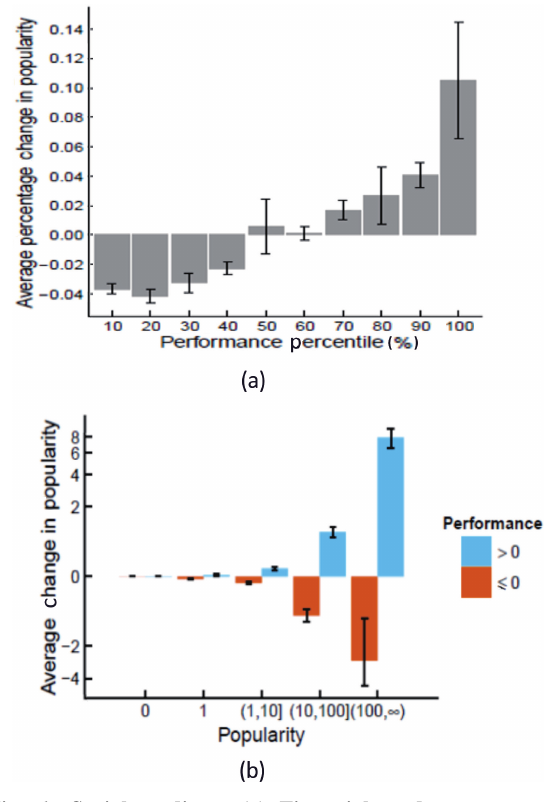
Fig. 6 Social trading: (a) Financial traders use recent performance in making decisions, but (b) this is modulated by using popularity signals as a prior probability that the trade is good, a strategy called distributed Thompson sampling. Using this strategy can produce much better return on investment as compared to individual trading [29]